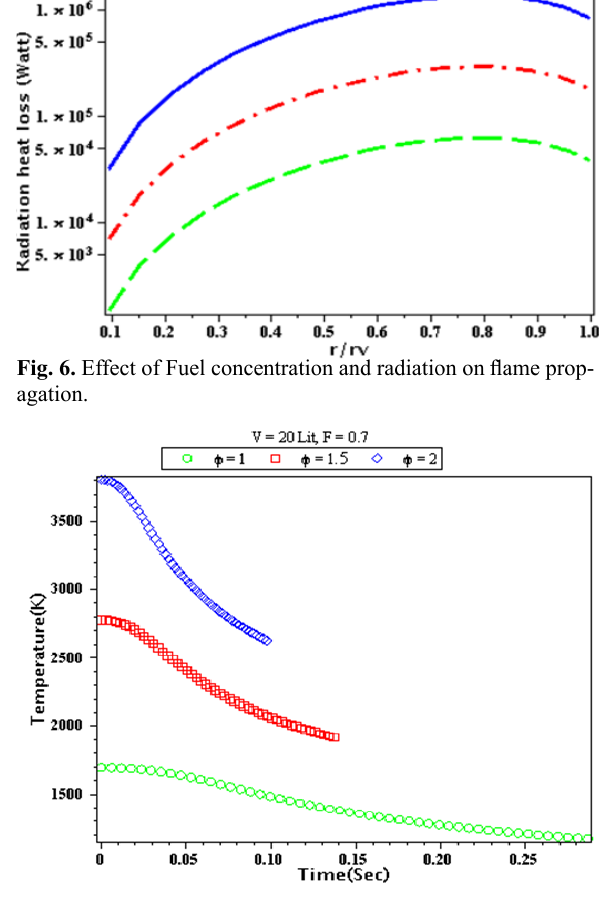
Fig. 7. Effect of vessel size on radiation heat loss.